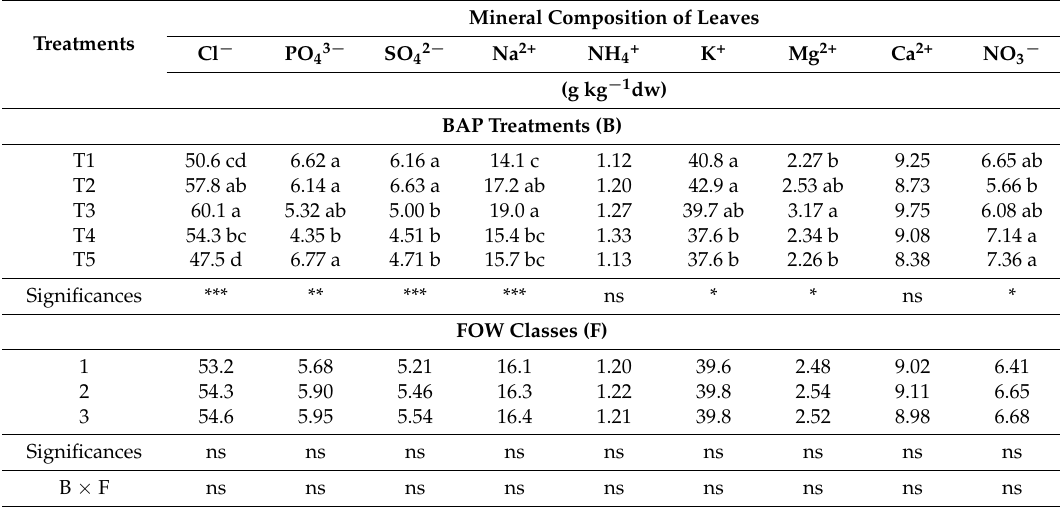
Mineral Composition of Leaves